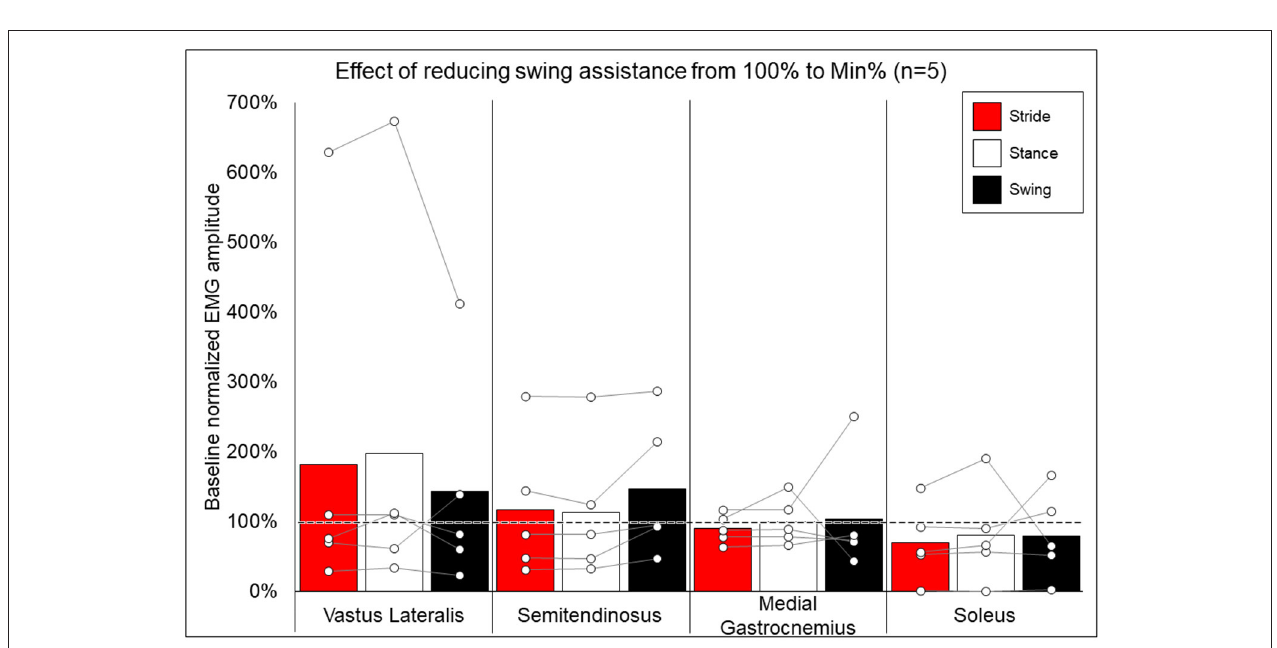
FIGURE 6 | Effects of reducing swing assistance from 100% to the minimum percent (Min%) achieved through training on select locomotor muscles. Bars representing group averages and dots representing individual participants show EMG amplitudes during Min% normalized as a percent of average EMG amplitudes when walking at 100% assistance (represented by the dotted line on the